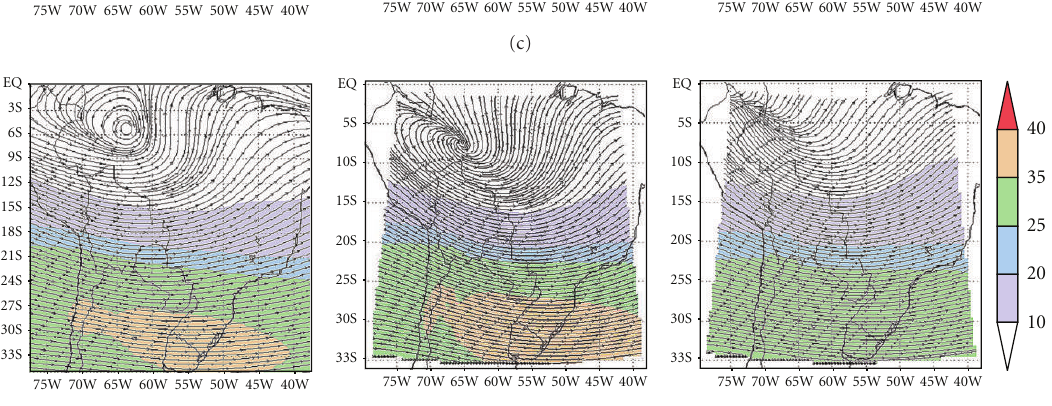
Figure 3: Same as Figure 2 but for upper level winds at 200